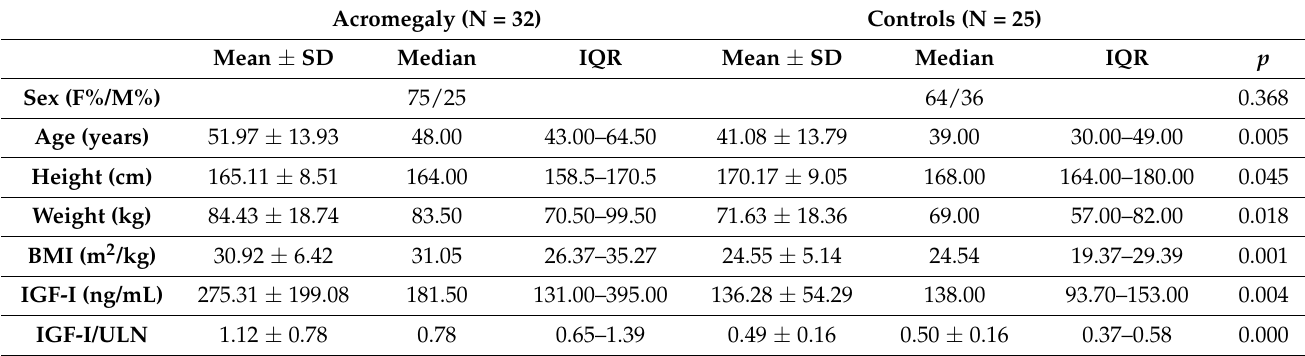
Table 1. General characteristics of acromegaly patients and the control